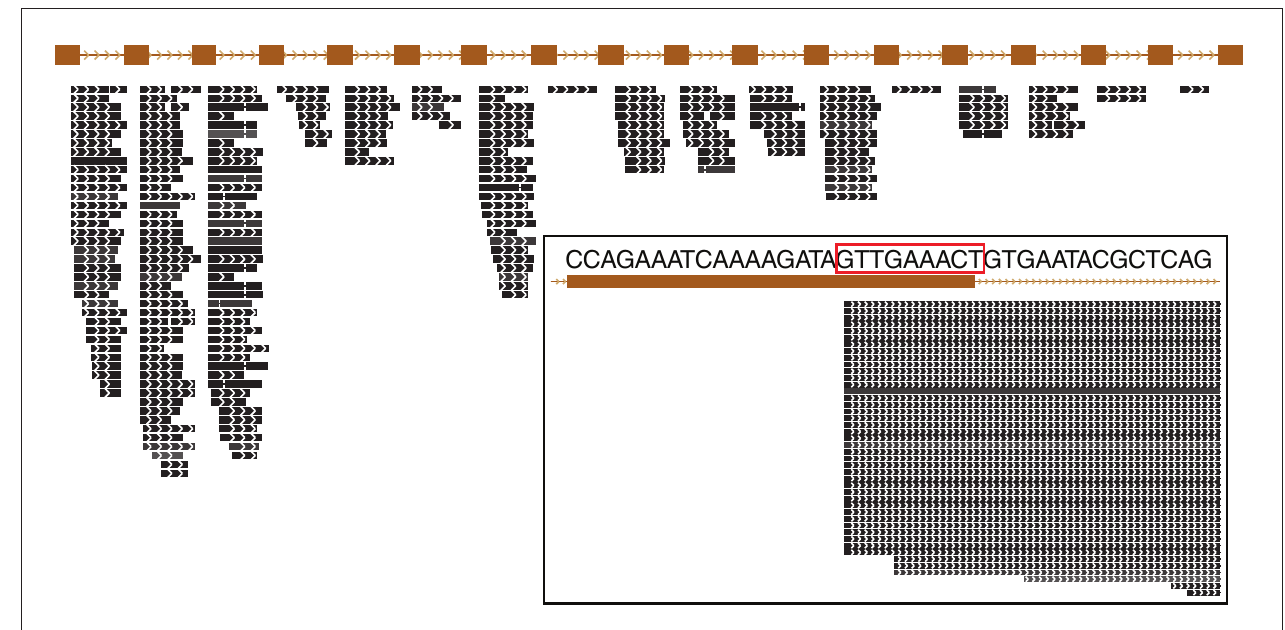
FIGURE 3 | Small RNA expressed from a typical CRISPR array in Pyrobaculum aerophilum . The crispr2 array is shown, depicting the near-identical repeat regions (brown rectangles) with intervening spacer sequences. Mature crRNA reads (black bars) that map uniquely to individual spacers within CRISPR arrays are shown with strand indicated by interior